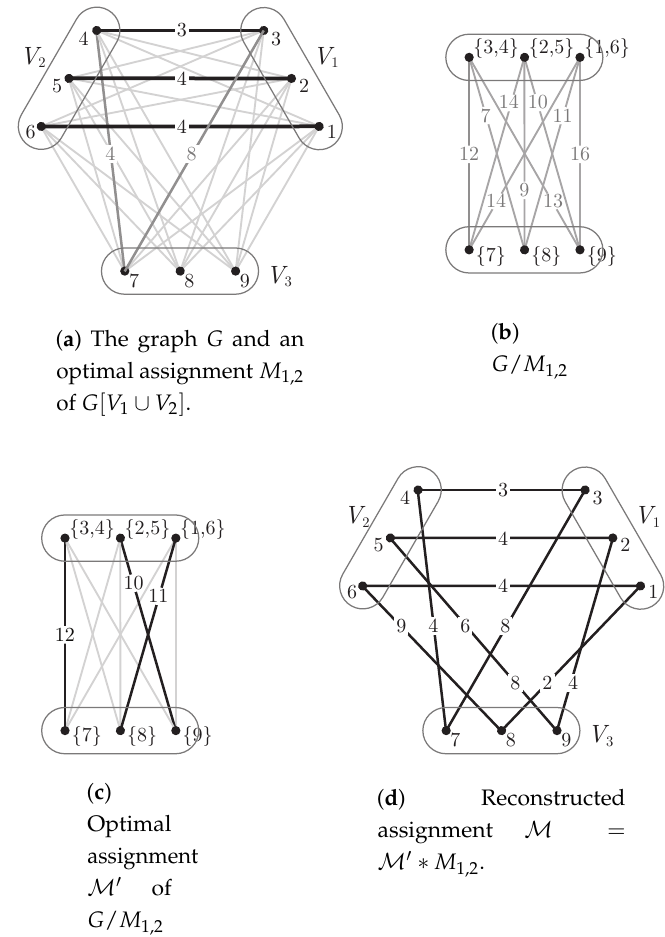
Figure 1. Application of Algorithm A m on a small